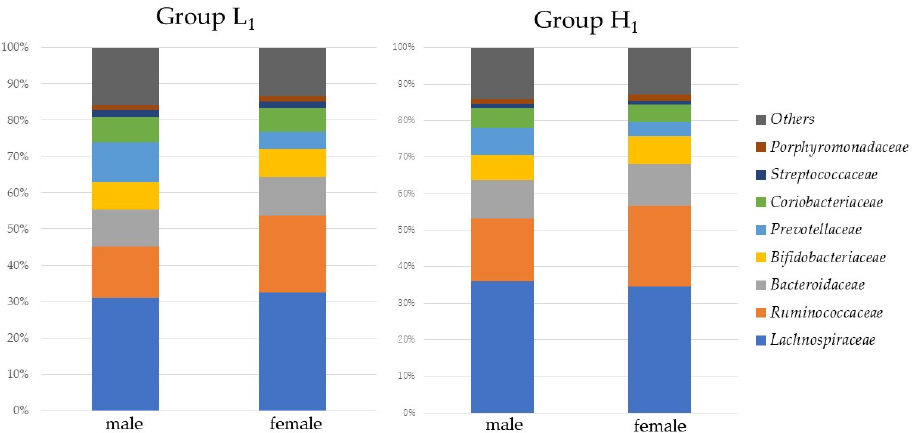
Figure 3. Comparison of the family relative abundance of gut microbiota in males and females for Group L 1 and Group H 1 . Group L 1 : Water-soluble dietary fiber intake < 2.62 g/day in 2017; Group H 1 : Water-soluble dietary fiber intake ≥ 2.62 g/day in 2017.